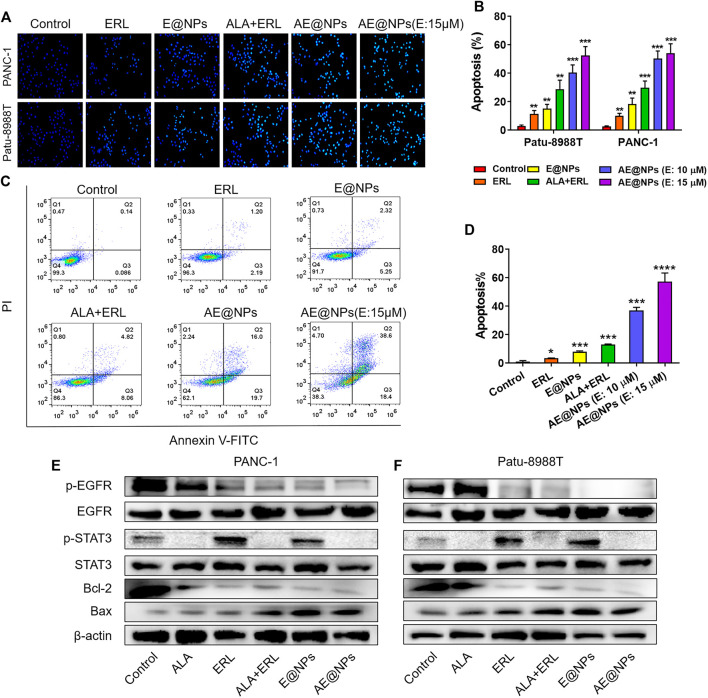
The underlying anticancer mechanisms of AE@NPs (A) the apoptosis induced by AE@NPs in PC cells (magnification: ×200) was assessed by Hoechst 33258 staining and also (B) quantitatively analyzed (C) Annexin V/propidium iodide (PI) staining was used to identify apoptosis, and (D) the percent of late-apoptosis was listed (E) PANC-1 and (F) Patu-8988T were treated with AE@NPs for 18 h, and then the protein levels of p-EGFR, EGFR, p-STAT3, STAT3 were determined by western blot. β-actin was used as the internal control. The data were shown as mean ± SD. *p < 0.05 **p < 0.01, ***p < 0.001, ****p < 0.0001, compared to the control group.